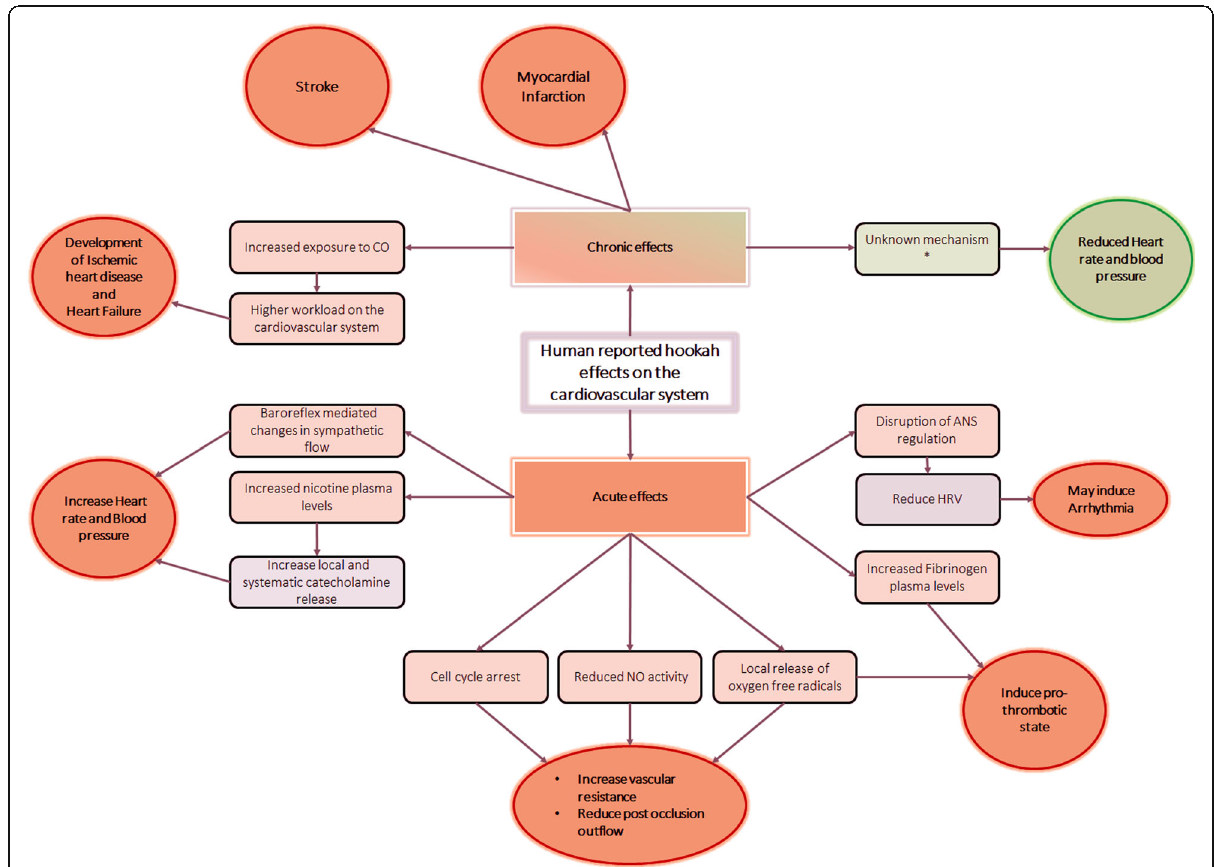
Fig. 6 Cardiovascular effects and their underlying mechanisms. These data are compiled from what is reported in clinical studies. *In a study performed in adolescents, the reduced heart rate and blood pressure may be linked to the “ abstinence of vaping ” for 12 h prior to testing